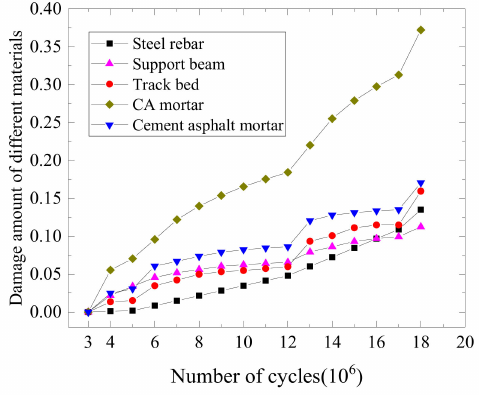
Figure 10. Damage curves of different materials.